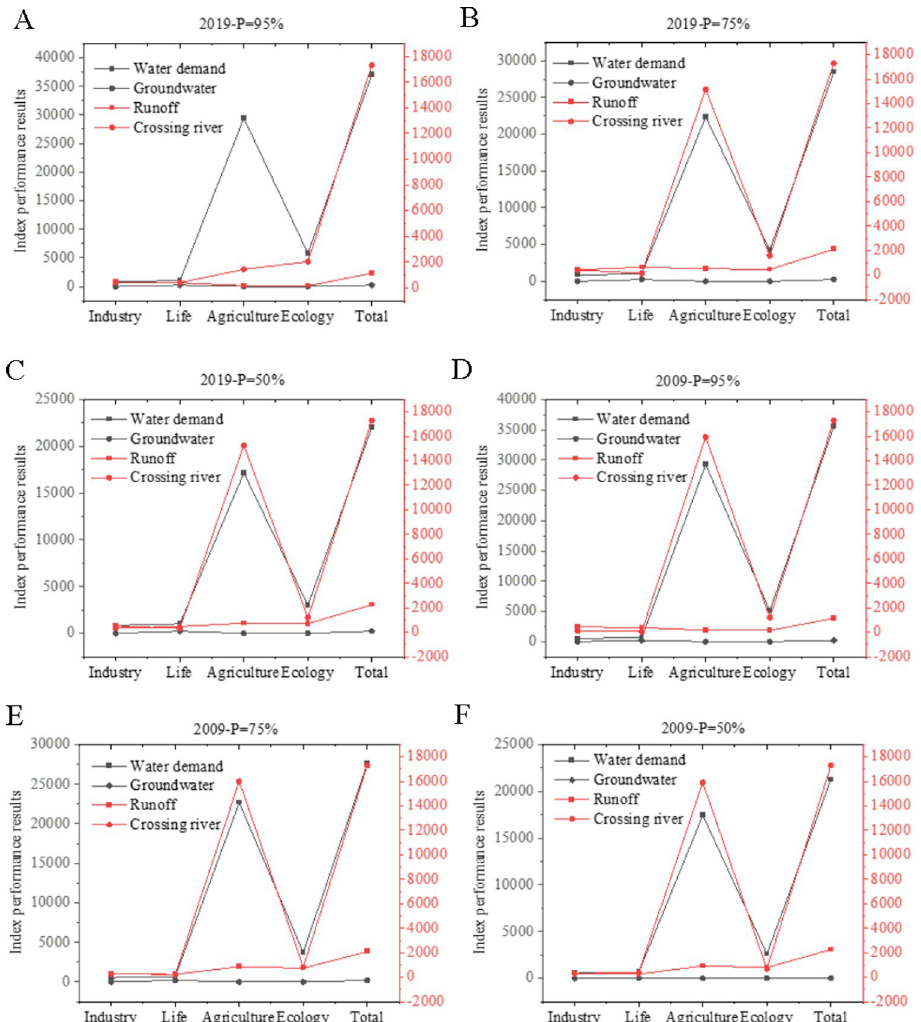
Fig 6. Water resource allocation results of the water demand volume, surface runoff, groundwater, and crossing